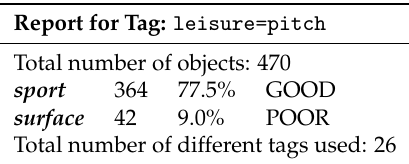
Table 2. The compliance of objects with the suggested tagging in the OSM Map Features wiki page for the target tag leisure=pitch is shown for Christchurch, New Zealand.